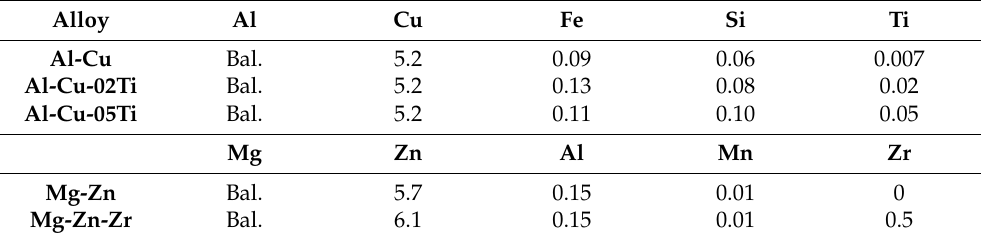
Table 1. Compositions of prepared Al-Cu and Mg-Zn alloys (wt.%). Alloy Al Cu Fe Si Ti Al-Cu